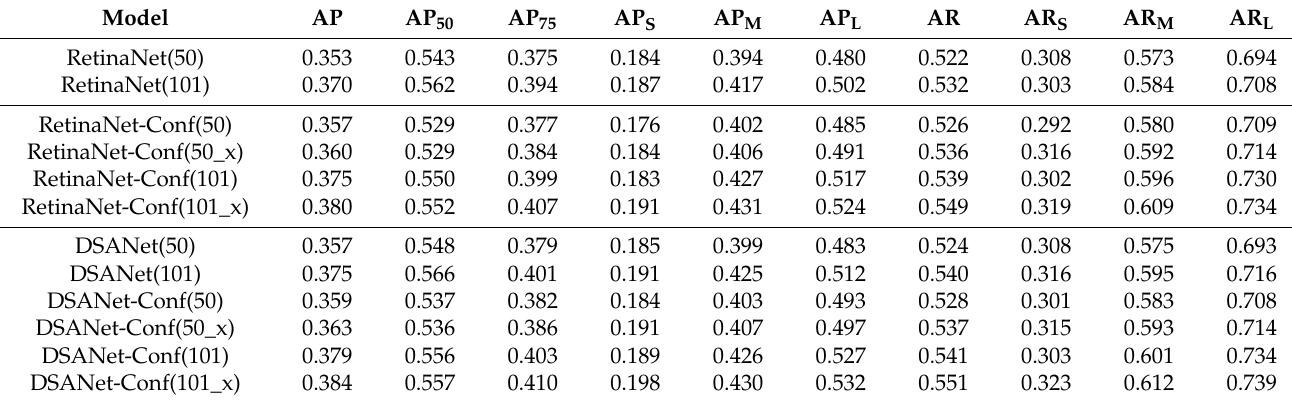
Table 6. Comparison of DSA module and object confidence task, where “50” or “101” in model names represent using ResNet50 or ResNet101 as backbone network. “x” represents using the product of classification score and object confidence to guide NMS